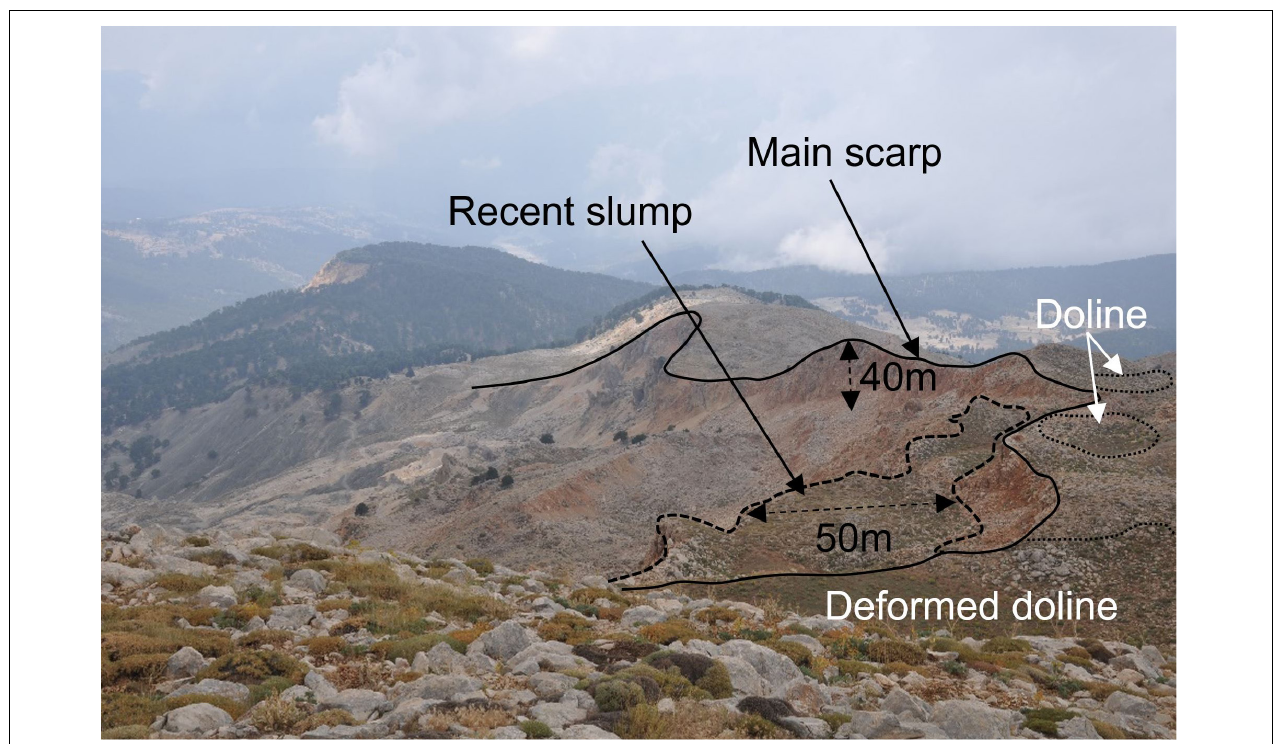
FIGURE 6 | Akdag main scarp and recent slumps inside the main scarp (in Figure 4 , viewpoints of photographs are marked).